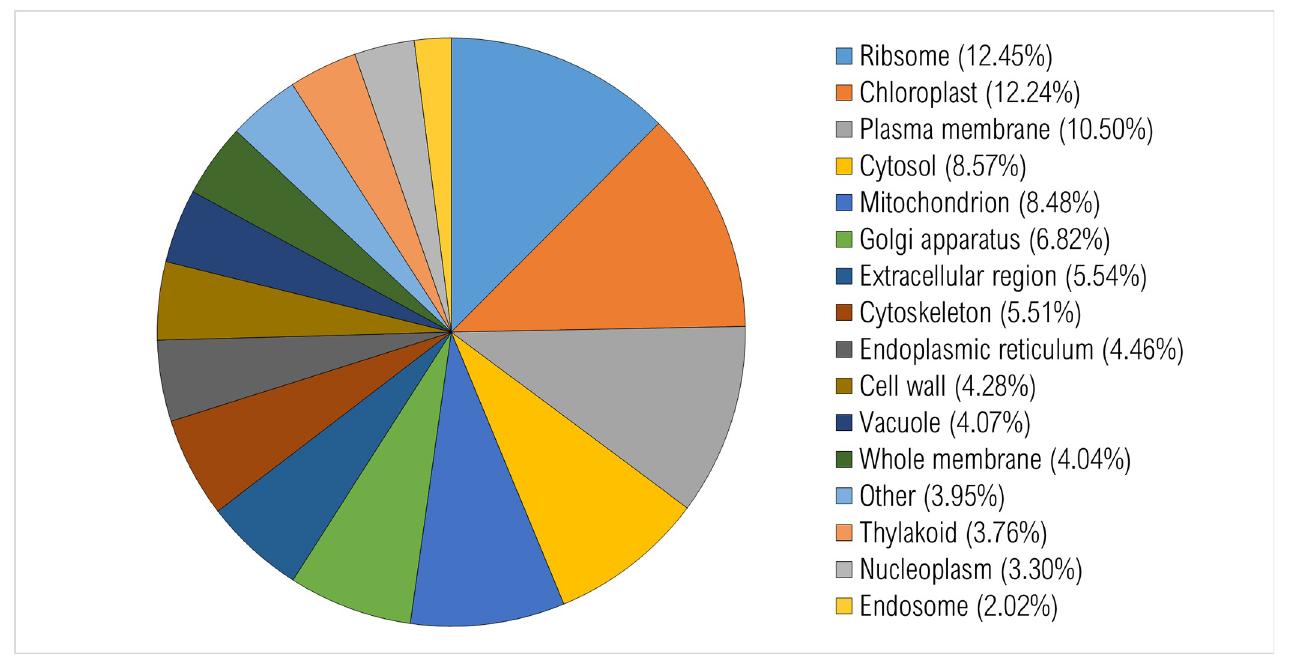
Fig 4. Percentage of transcripts in Populus tremuloides control samples. A total of 3268 transcripts were assigned ontology and grouped by cellular compartment using BLAST2GO. Categories under 2% were grouped together and classified as “other”.